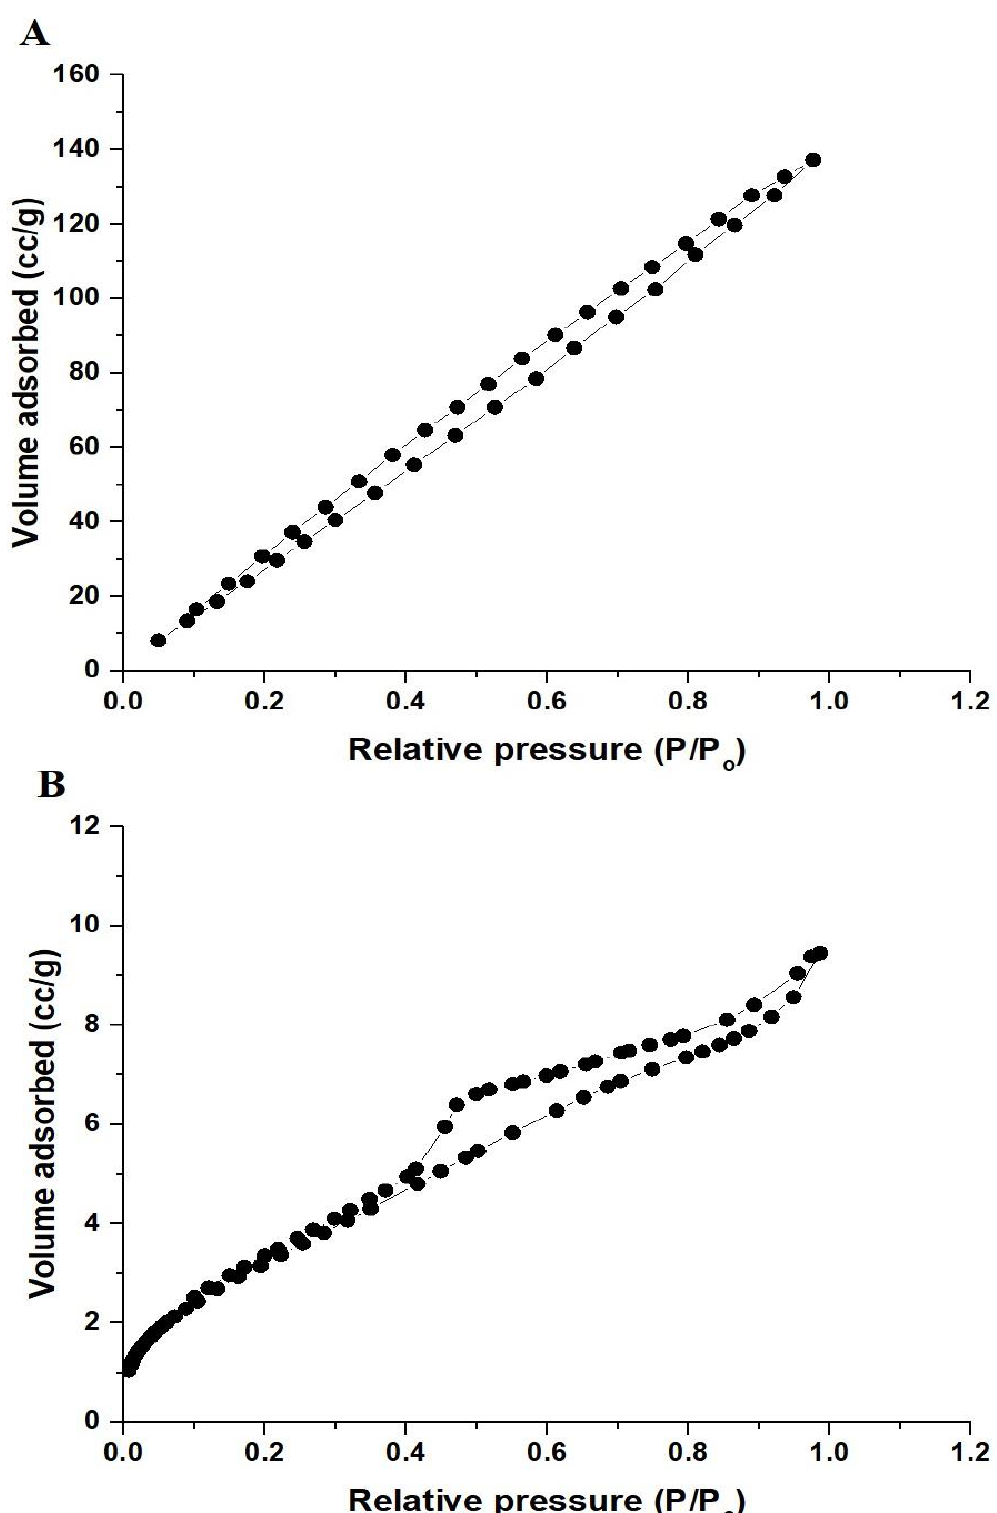
Figure 5. The N 2 adsorption/desorption isotherms of the F1 (nanostructures) ( A ) and F1S (nanocom- posites) ( B ) samples.